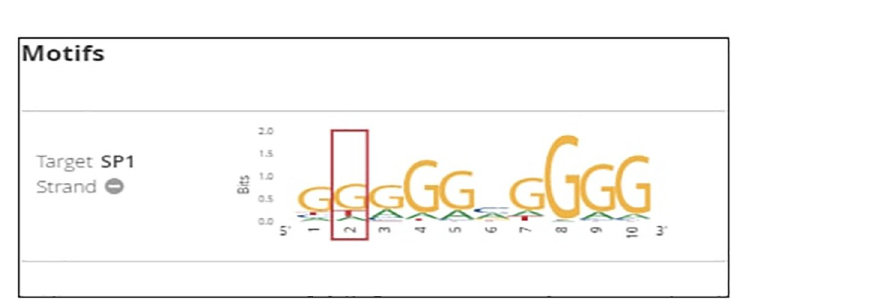
Fig 4. Regulaome DB prediction of affected transcription factor due to the tumor necrosis factor (TNF)- α -308 G/ A gene polymorphism (rs1800629), the binding sites of specificity protein 1 (SP1) are